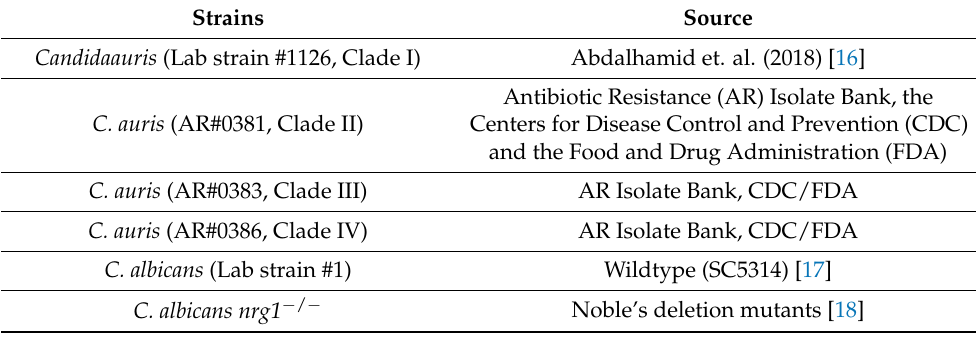
Table 1. List of Candida fungal strains used in this study. Strains Source Candidaauris (Lab strain #1126, Clade